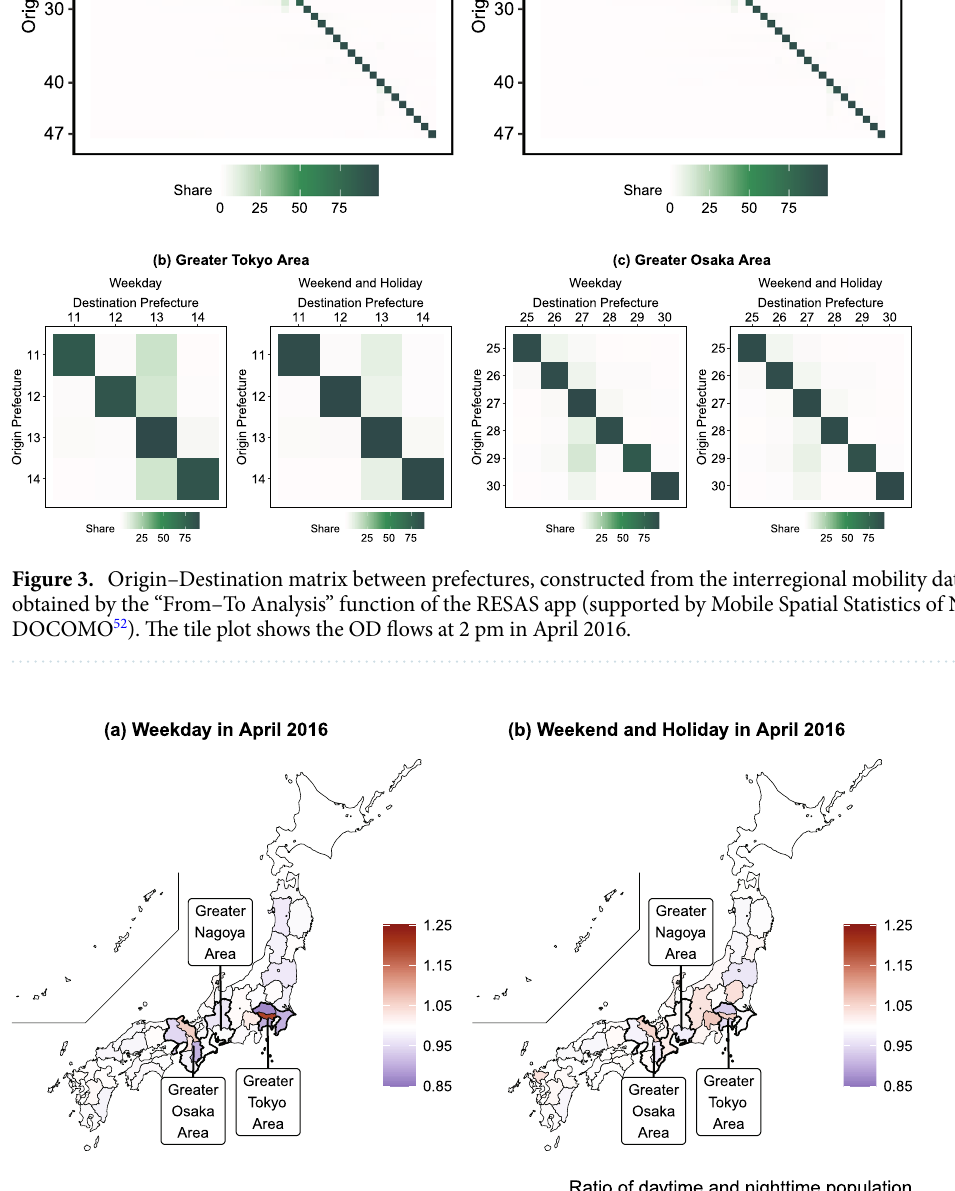
Figure 4. Ratio of daytime and nighttime populations on weekdays and at weekends in April 2016, created from the interregional mobility data obtained by the “From–To Analysis” function of the RESAS app (supported by Mobile Spatial Statistics of NTT DOCOMO 52